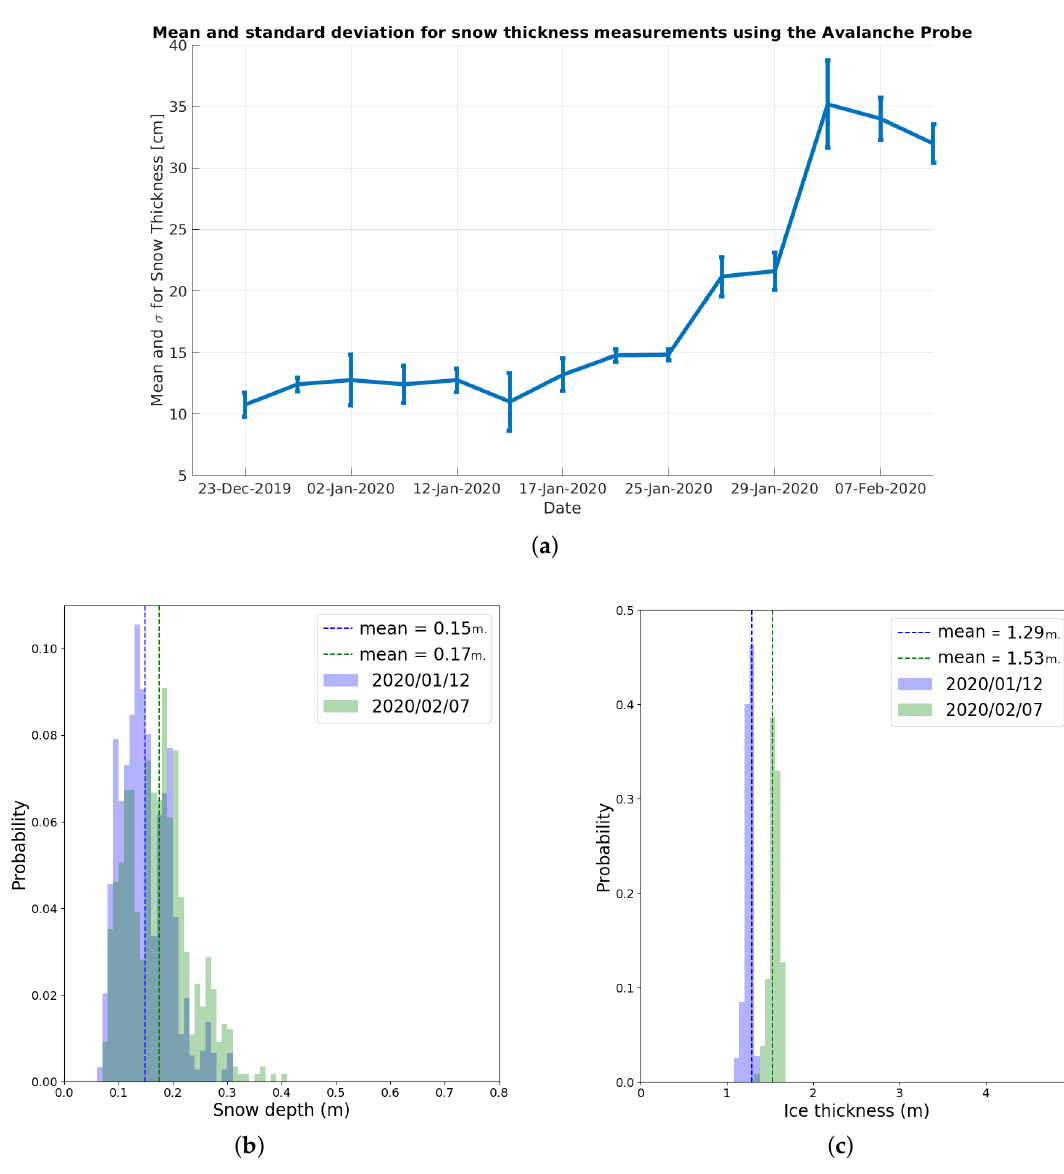
Figure 3. ( a ) Avalanche probe measurements in the vicinity of the GNSS-R instrument; ( b ) Snow depth and ( c ) Sea-ice thickness PDF for different dates in the level ice area adjacent to Remote Sensing site measured by Magnaprobe and GEM-2.